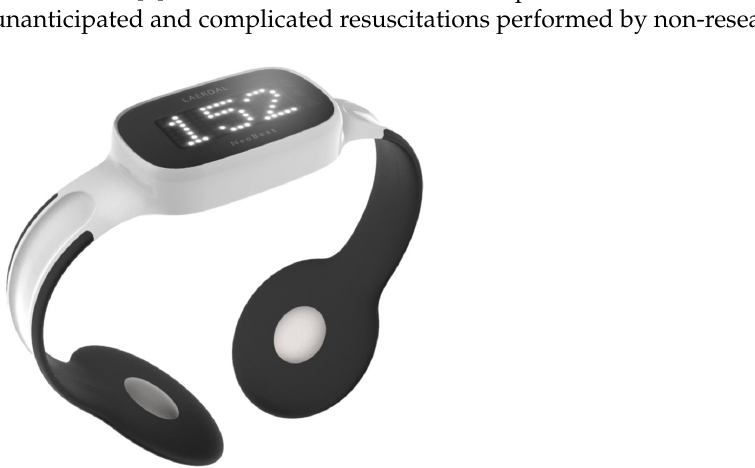
Figure 1. NeoBeat Newborn Heart Rate Meter (Laerdal Global Health, Stavanger, Norway) low- cost, dry-electrode ECG technology, produced for heart rate monitoring of newborns immediately after birth and continuously during